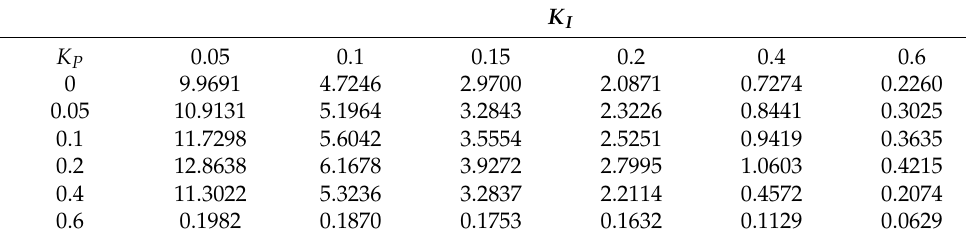
Table 8. Delay margin ( G m = 2, Φ m = 30 ◦